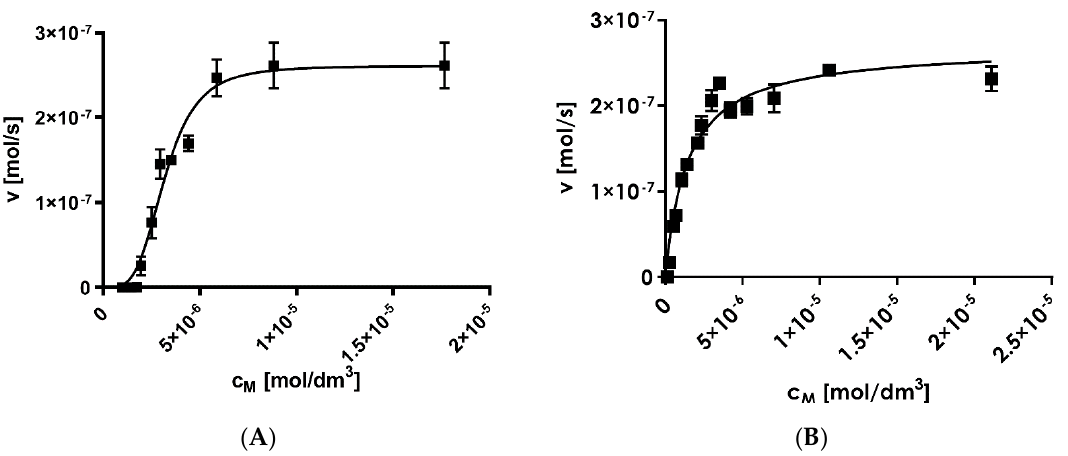
Figure 5. 20S proteasome activity in the presence of selective proteasome inhibitors. Compounds used in the study: carfilzomib, selective inhibitor of the β5 subunit; NCOO1, selective inhibitor of the β1 subunit, PR671A, selective inhibitor of the β2 subunit; epoxomicin, general inhibitor of proteasome activity.